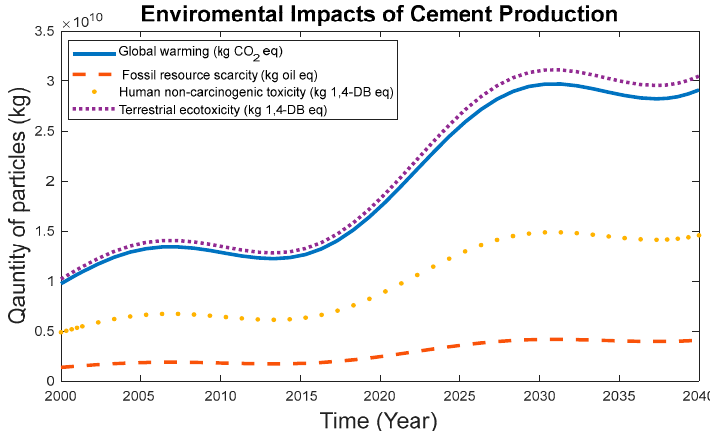
Figure 4. Plot showing a possible long-term environmental impact of cement production in South Africa. Global warming, measured in kg CO 2 eq, terrestrial ecotoxicity measured in kg 1,4-DB eq, fossil resource scarcity measured in kg oil eq and human non-carcinogenic toxicity measured in kg 1,4-DB eq.